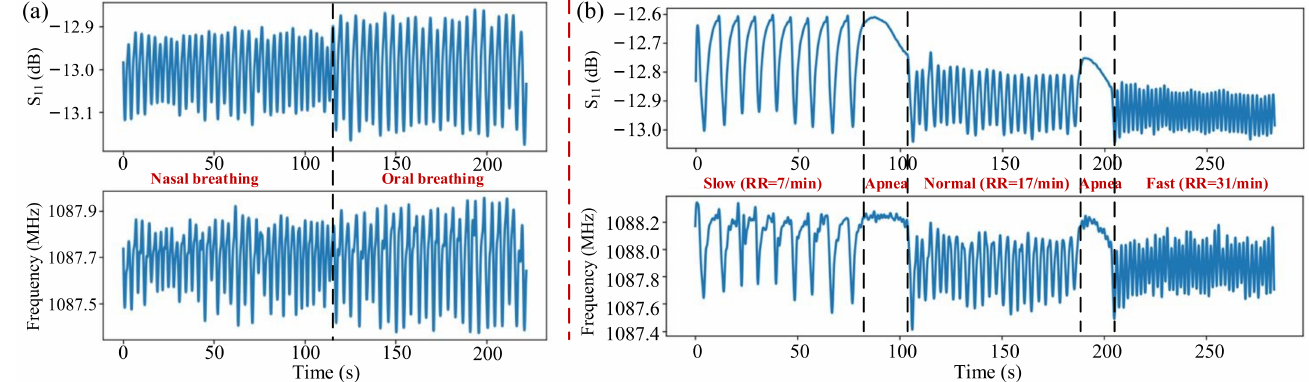
Figure 11. ( a ) S 11 and frequency responses with breathing time in case of nasal breathing and oral breathing modes and ( b ) nasal breathing with different breathing rates: slow breath, apnea, normal breath, and fast